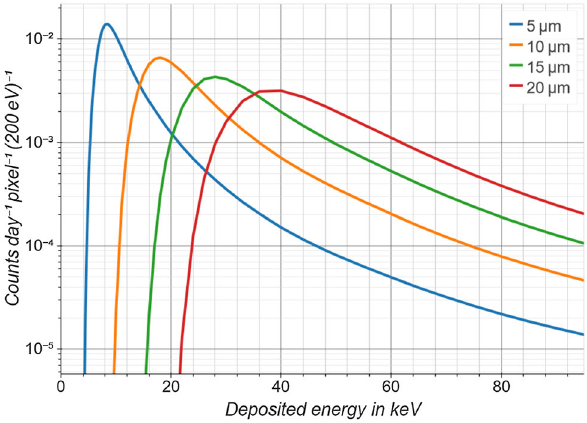
Fig. 3 Distribution of the energy deposited by muons passing gold absorbers with areas of 180 µ m × 180 µ m and different thicknesses [16–18,20]. The fraction of muons with short path lengthes are highest forthinabsorbersandtherefore,theprobabilitytodepositasmallenergy is largest for these thicknesses. For gold absorbers with a thickness of 10 µ m and lower, muons depositing less than 6 keV could be neglected. However, by considering also resonances with the gold shells, the low energy edge could be smeared and so, more muons depositing less